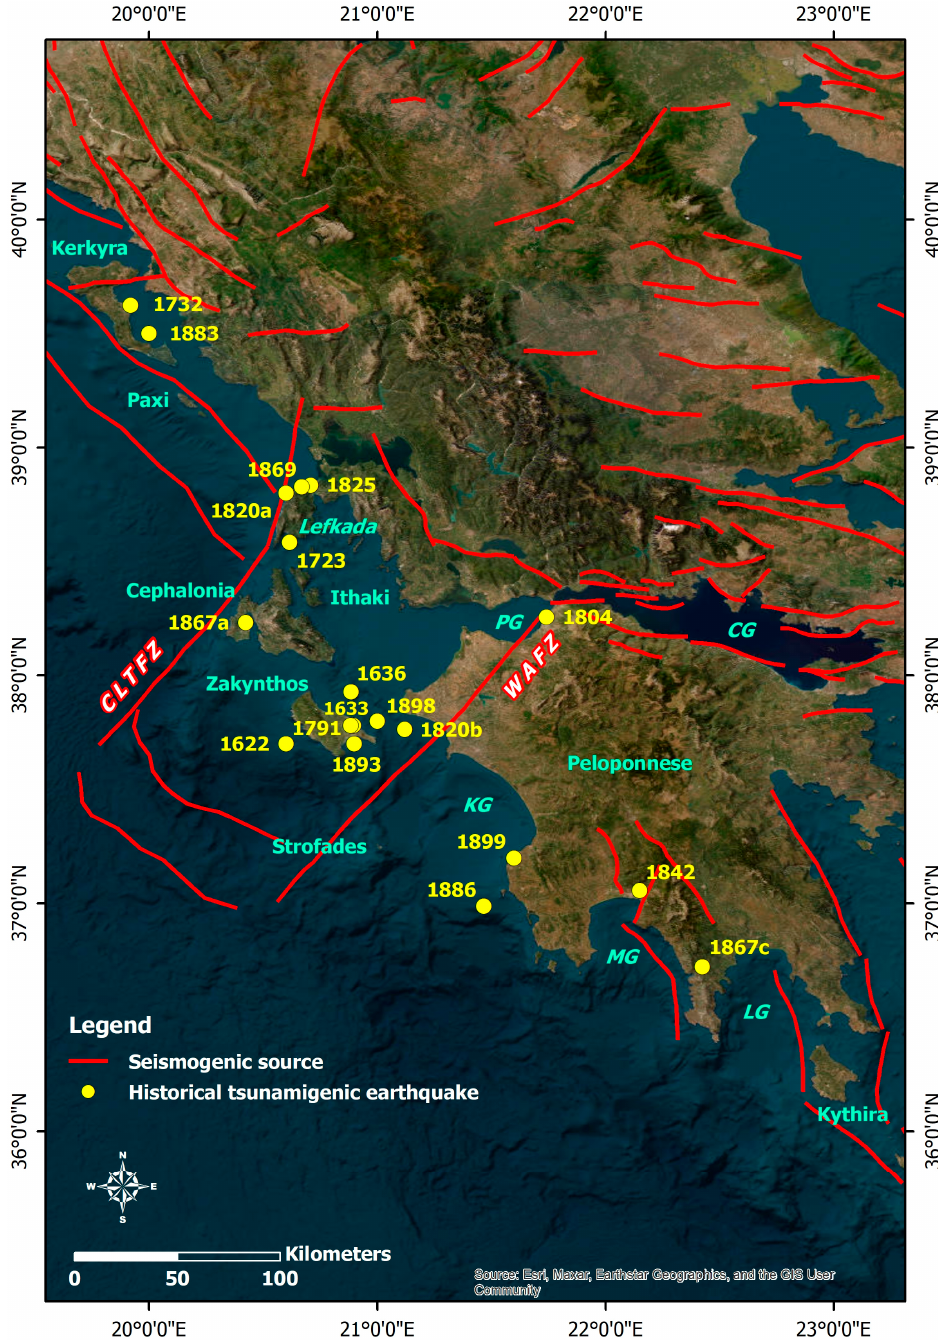
Figure 6. Spatial distribution of epicenters of the historical tsunamigenic earthquakes and occurrence dates in the Ionian Sea and the offshore western and southern Peloponnese along with the seismogenic sources in the study area. The central part of the study area is dominated by strike-slip structures which comprise the Cephalonia–Lefkada Transform Fault Zone (CLTFZ) and the Western Achaia Fault Zone (WAFZ), both responsible for the generation of large and destructive strike-slip